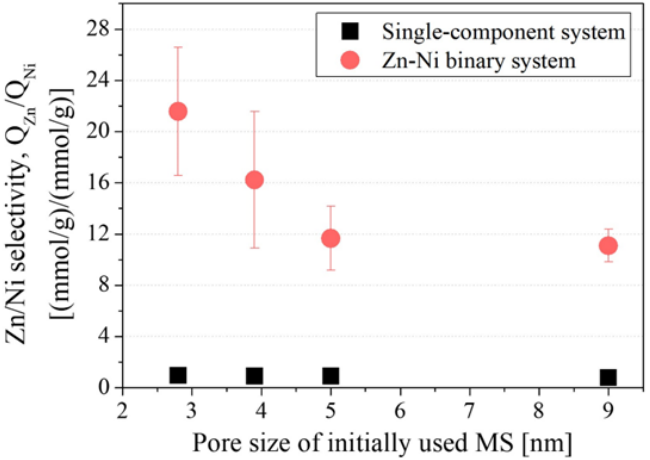
Figure 11. Zn/Ni selectivity of amine-modified MS with different initial MS pore sizes in single- component and binary systems (Zn = Ni = 1.5 mmol/L). Plots of the single-component system are ratios of Q Zn and Q Ni obtained in the previous single-component adsorption experiment in the presence of only Zn or Ni. Error bars indicate the standard deviation ( ± σ ).